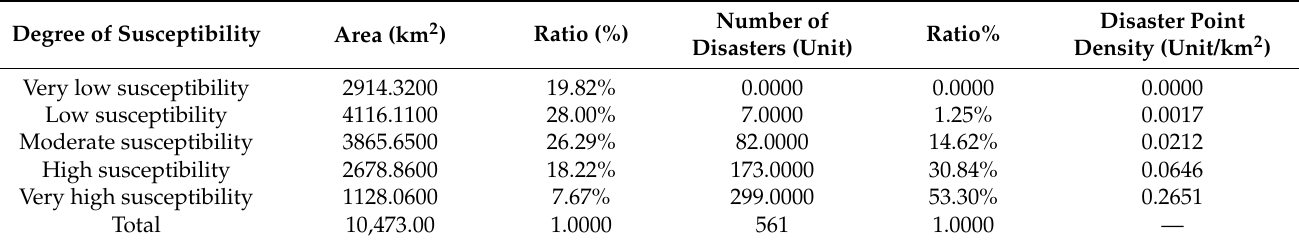
Table 5. Statistical table of SVM model susceptibility.